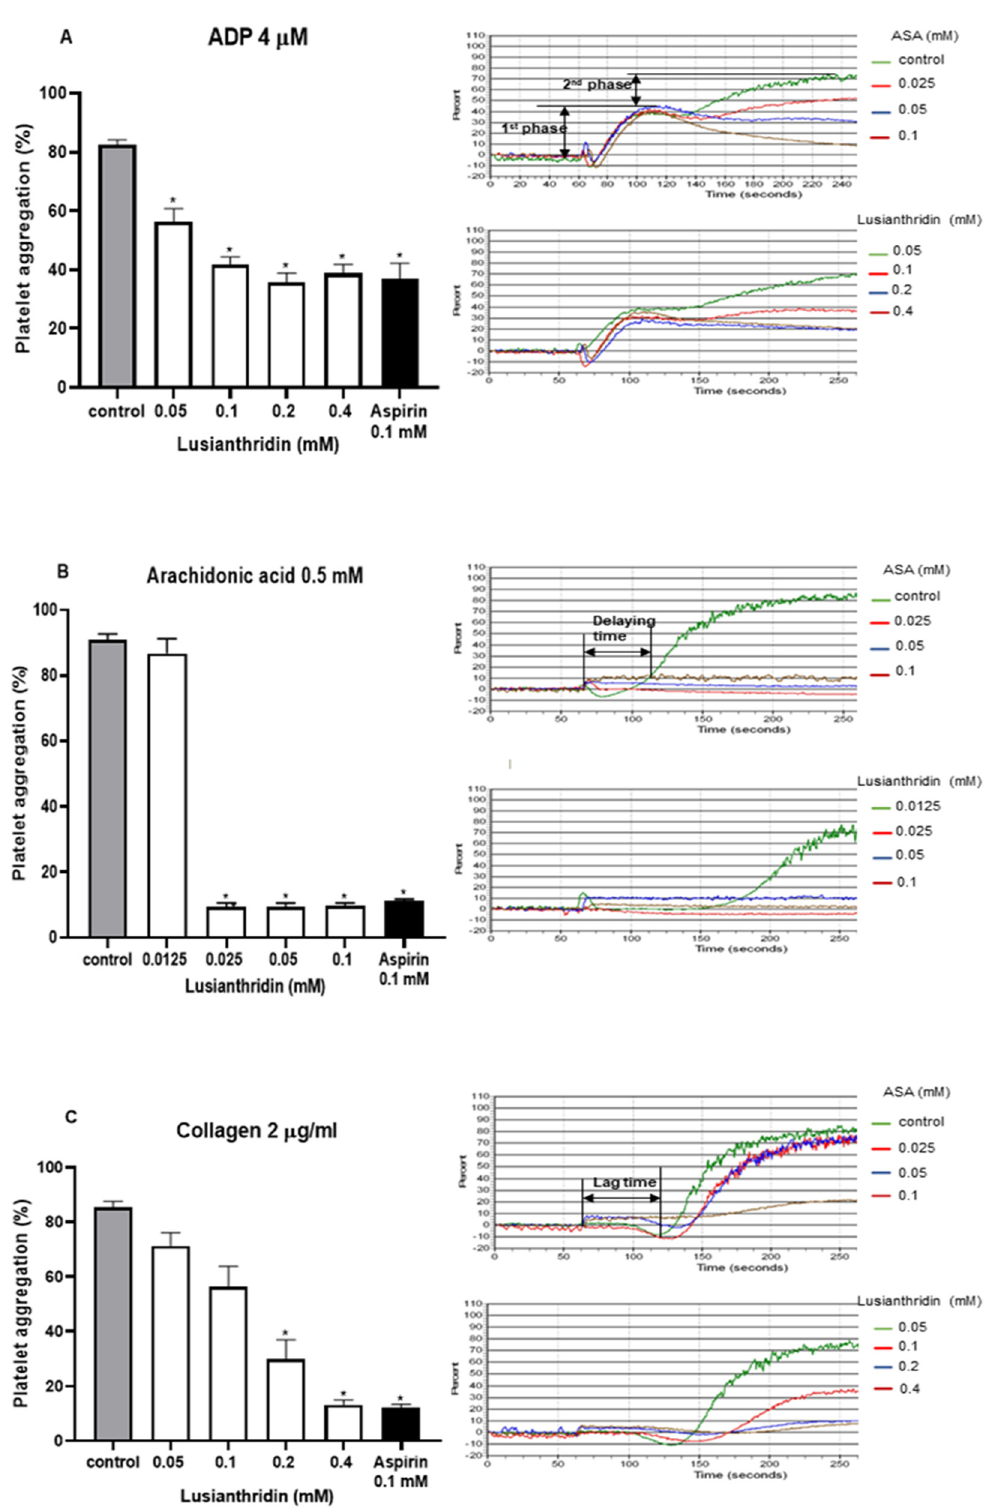
Figure 1. Effects of lusianthridin on agonist-induced platelet aggregation. Platelets were pre-incubated with 0.5% DMSO (vehicle control), lusianthridin, or aspirin at 37 °C for 5 min and then agonists were added to stimulate platelet aggregation. ( A ) ADP 4 µM. ( B ) Arachidonic acid 0.5 mM, the delaying time is the time starting from addition of an agonist until platelet aggregation. ( C ) Collagen 2 µg/mL, the lag time is a time starting from addition of an agonist until a platelet shape change. Data are presented as percent aggregation (means ± SEMs; n = 5). * p < 0.05 compared with those of vehicle control.